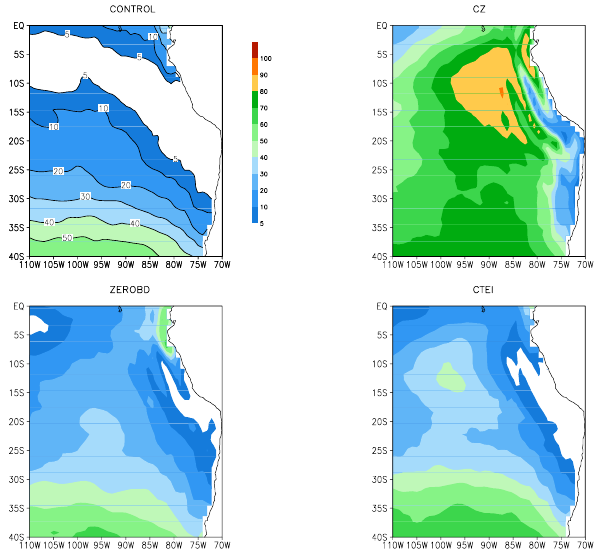
Fig. 3. As in Fig. 1 except for low clouds.